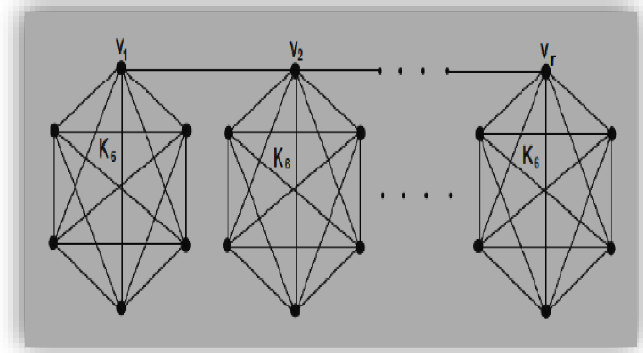
Figure 5. G r (K s, v ) over K s . Figure 5. G r (K s , v ) over K s . Figure 5. G r (K s , v ) over K s .